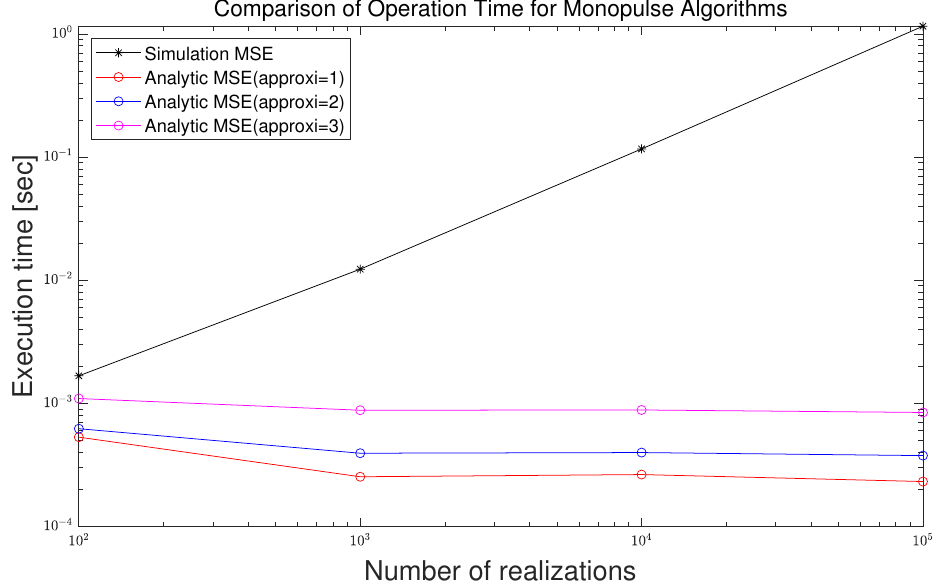
Figure 13. Comparison of execution time as a function of the number of realizations for the simulated and analytical MSEs.